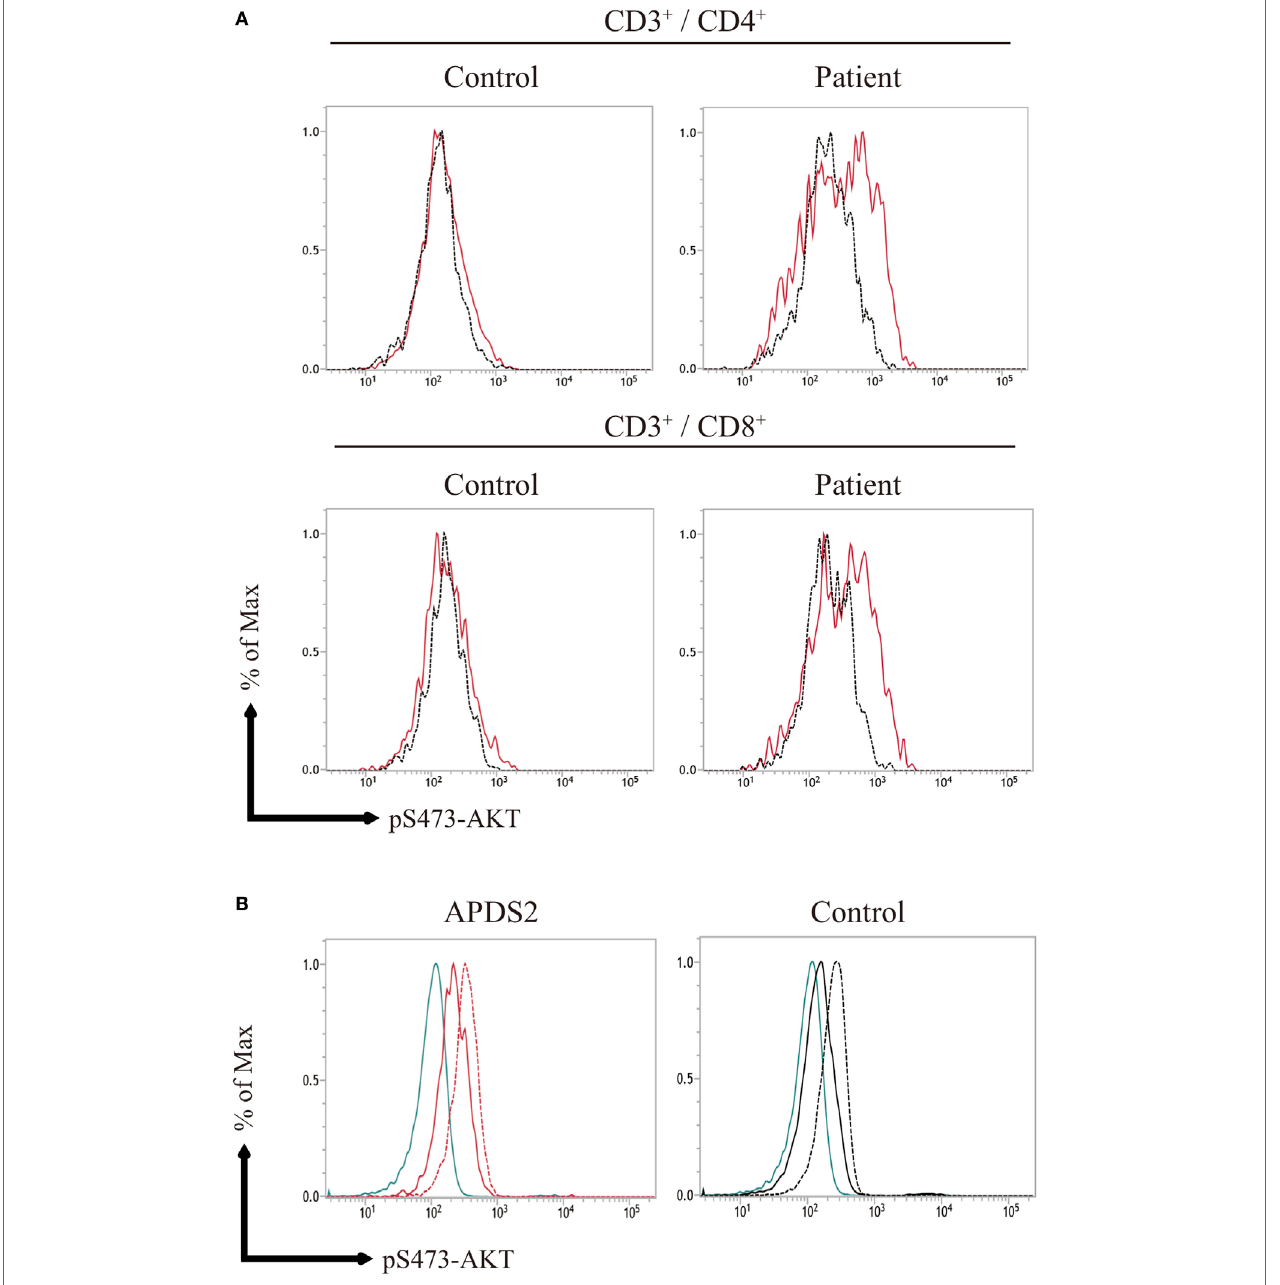
FigUre 4 | (a) AKT phosphorylation (pAKT) expression in activated T cells, (B) pAKT expression CD19 + B cells stimulated with CD40L and IL-4. (a) The level of pAKT in T cells was assessed by flow cytometry in activated PI3K δ syndrome 2 patient (P1) and healthy controls (representative result from two controls is shown). The total number of events analyzed was 2,000. Red bold line: no treatment and black dotted line: p110 δ inhibitor treatment. (B) pAKT expression in CD19 + B cells from (P1) and healthy control following stimulation with CD40L and IL-4. Blue line: isotype control, black and red solid line: no treatment, and black and red dot line: CD40L and IL-4